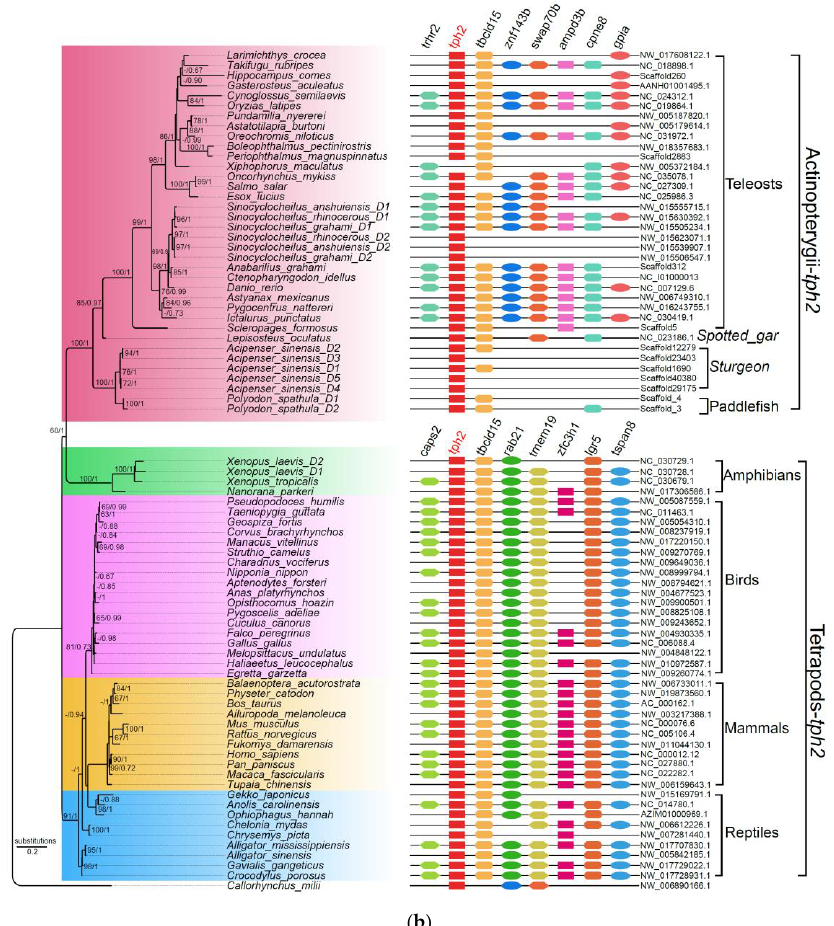
Figure 2. Phylogenetic trees and genome synteny of tph1 and tph2 in vertebrates. ( a ) The phylogenetic tree was generated from 105 TPH1 protein sequences (the left part), and the synteny data of tph1 (the right part) are presented for confirmation. ( b ) The phylogenetic tree was generated from 79 TPH2 protein sequences (the left part), and the synteny data of tph2 (the right part) are presented for validation. Numbers on the branches from left to right are bootstrap values generated in the PhyML reconstruction and the Bayesian posterior probabilities obtained in the Bayesian inference, respectively. The bootstrap values under 60% and posterior probabilities less than 0.65 are not shown.